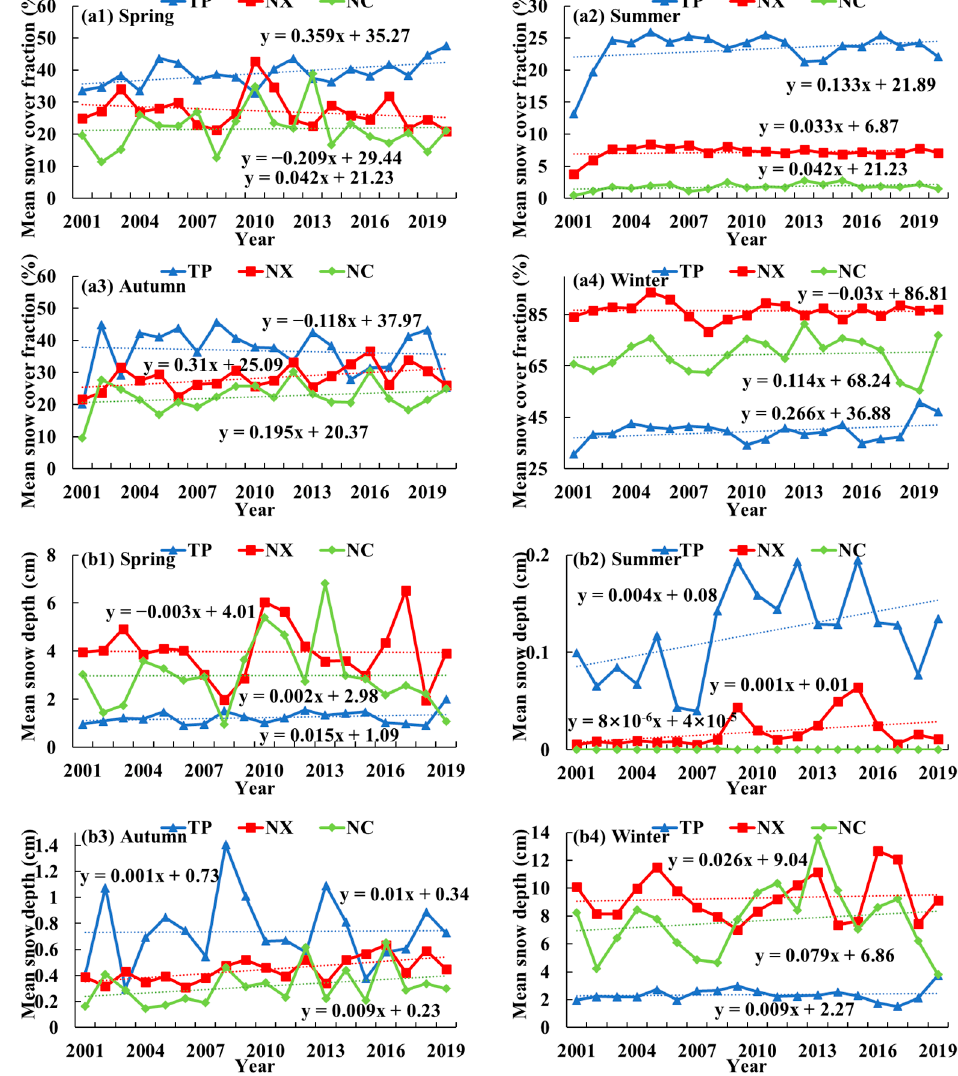
Figure 3. Annual variations in the SCF ( a ) and SD ( b ) in spring ( a1 , b1 ), summer ( a2 , b2 ), autumn ( a3 , b3 ), and winter ( a4 , b4 ) in the TP, NX, and NC from 2001 to 2019 or 2020. The blue line represents the TP, the red line represents NX, and the green line represents NC.